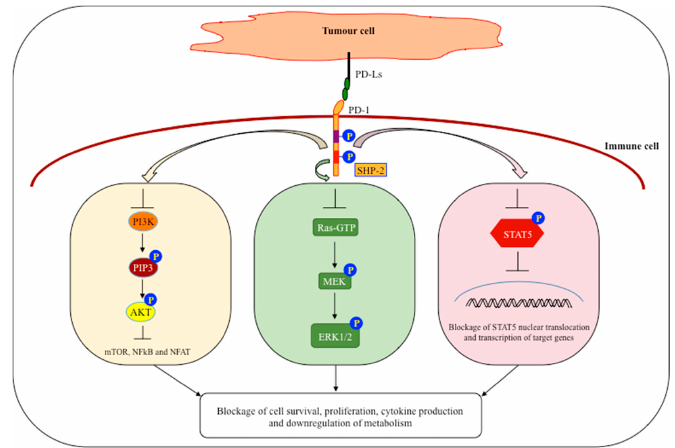
Figure 1. Major signalling pathways affected by the programmed cell death protein 1 (PD-1)/programmed death-ligands (PD-Ls) axis activation. In pathological conditions, the interaction between PD-1, expressed on immune cells, and its ligands upregulated by tumour cells, promotes inhibition of both the innate and the adaptive immune response. In particular, upon PD-1/PD-Ls complex formation, the tyrosine residues present in both the ITIM (purple rectangle) and ITSM (red rectangle) domains of PD-1 become phosphorylated and recruit SHP2, a key step for modulation of downstream molecular pathways. Indeed, PD-1 can block PI3K and Ras activation, which suppresses the signals delivered by the PIP3-AKT-mTOR and MEK-ERK MAP kinase pathways, respectively. In addition, inhibition of STAT5 phosphorylation impairs its nuclear translocation and blocks transcription of target genes. These inhibitory signals act together to modulate metabolic reprogramming and dampen cell proliferation, di ff erentiation and survival as well as cytokine